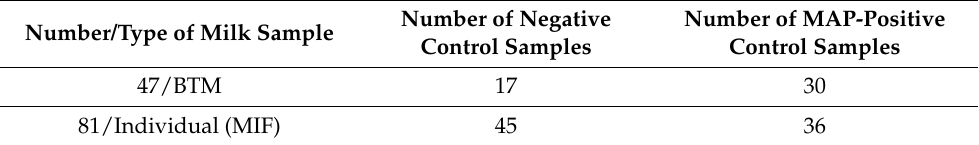
Table 1. Distribution of samples of bulk tank milk (BTM) and individual (MIF) milk into two categories, healthy or